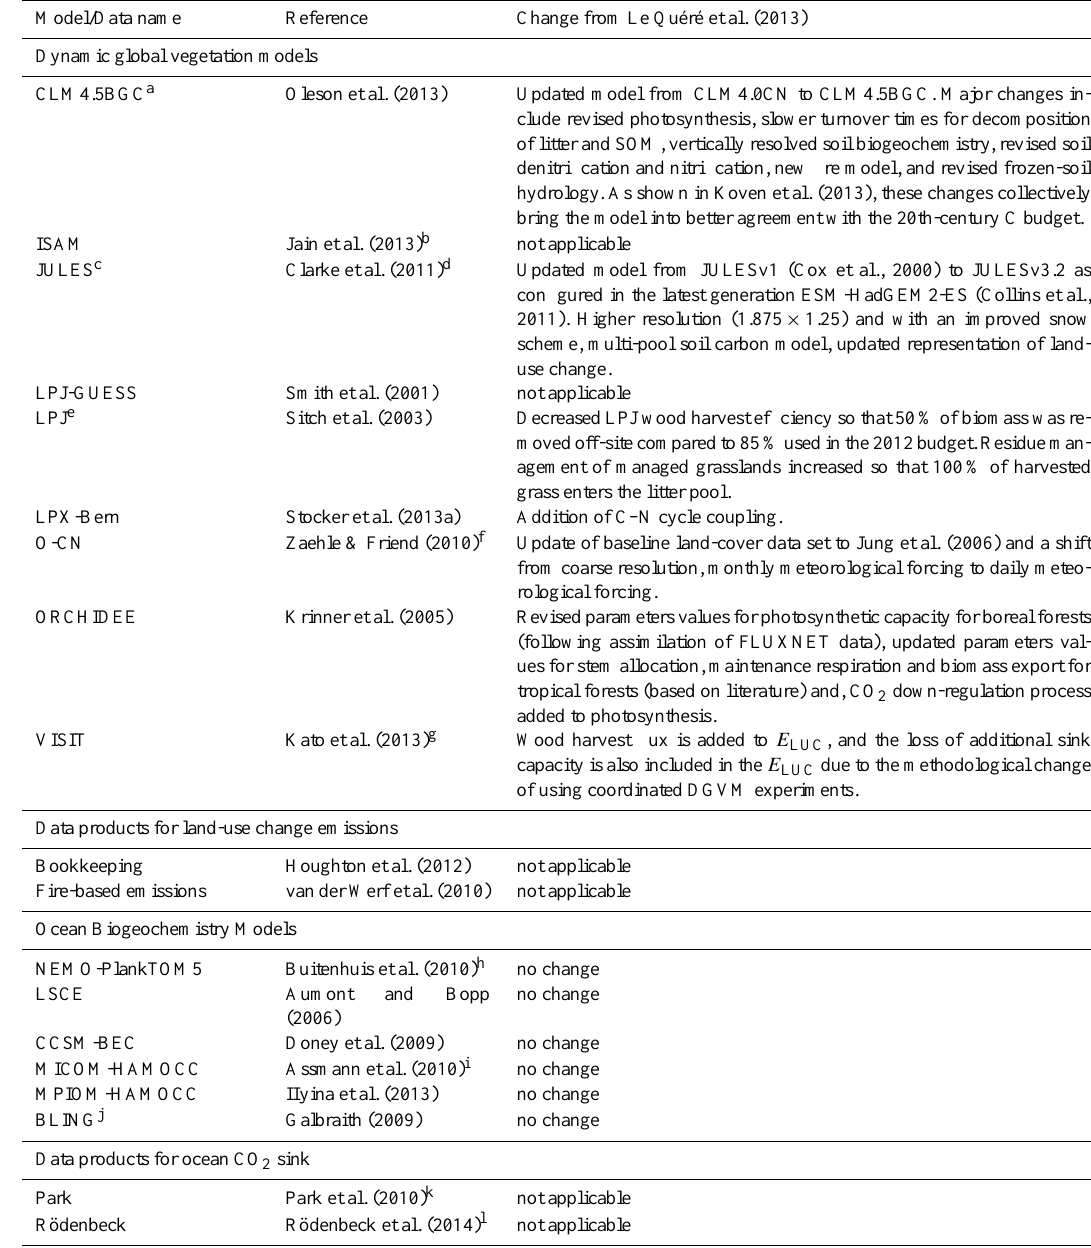
Table 6. References for the process models and data products included in Fig.